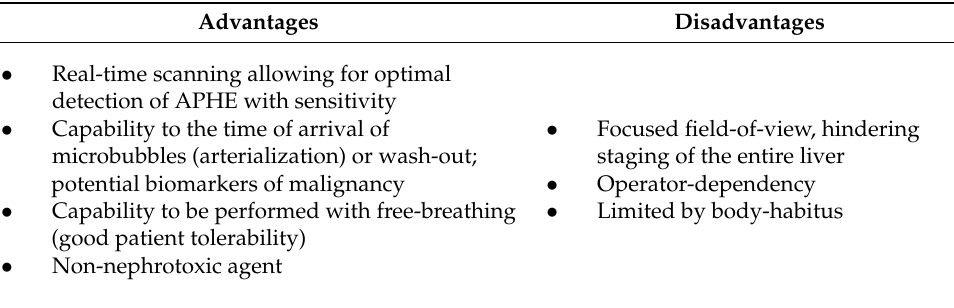
Figure 3. A regenerative nodule in liver cirrhosis. B-mode ( a ) depicted a rounded hypo-echoic nodule (arrowhead) with smooth border. CEUS ( b ) showed that the nodule (outlined by the ar- rowheads) demonstrated enhancement identical to the adjacent parenchyma with no arterial phase hyperenhancement or wash-out. These findings are in keeping with a regenerative nodule. Table 1. Advantages and disadvantages of CEUS for diagnosis of HCC. Advantages